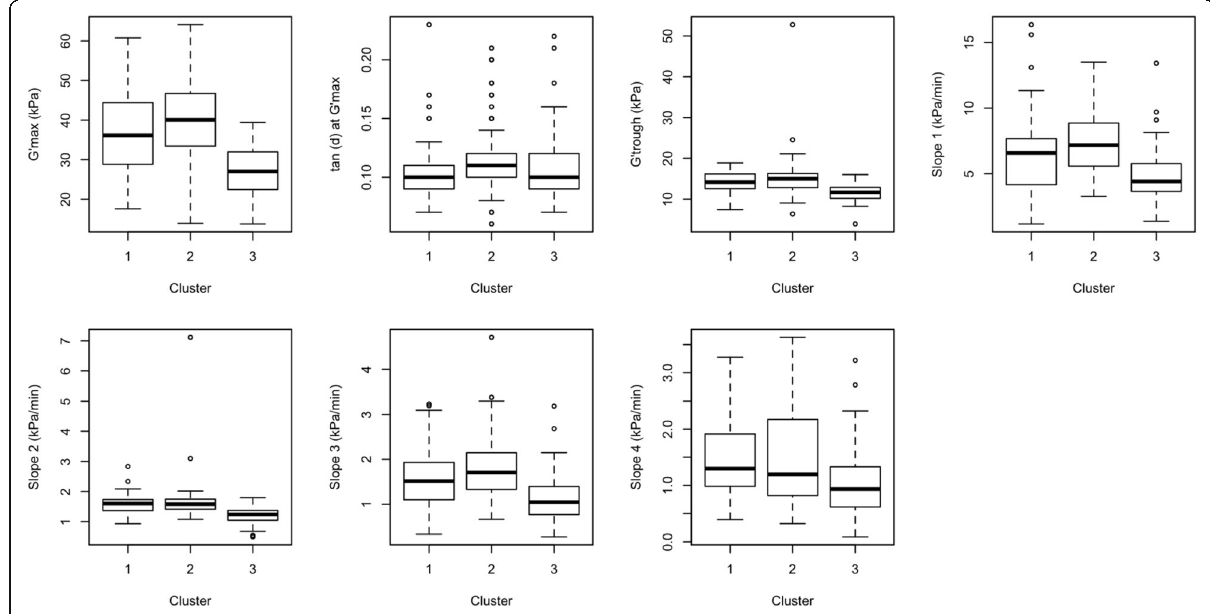
Fig. 3 Boxplots of the three clusters of rice samples for rheometry parameters: G ’ max , tan ( δ ) at G ’ max , G ’ trough , Slope 1 (G ’ ), Slope 2 (G ’ ), Slope 3 (G ” ), Slope 4 (G ” )